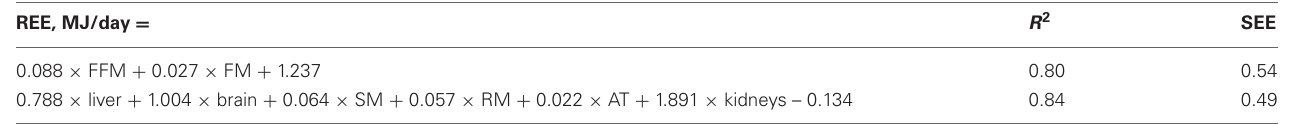
SM, skeletal muscle; RM, residual mass; AT, adipose